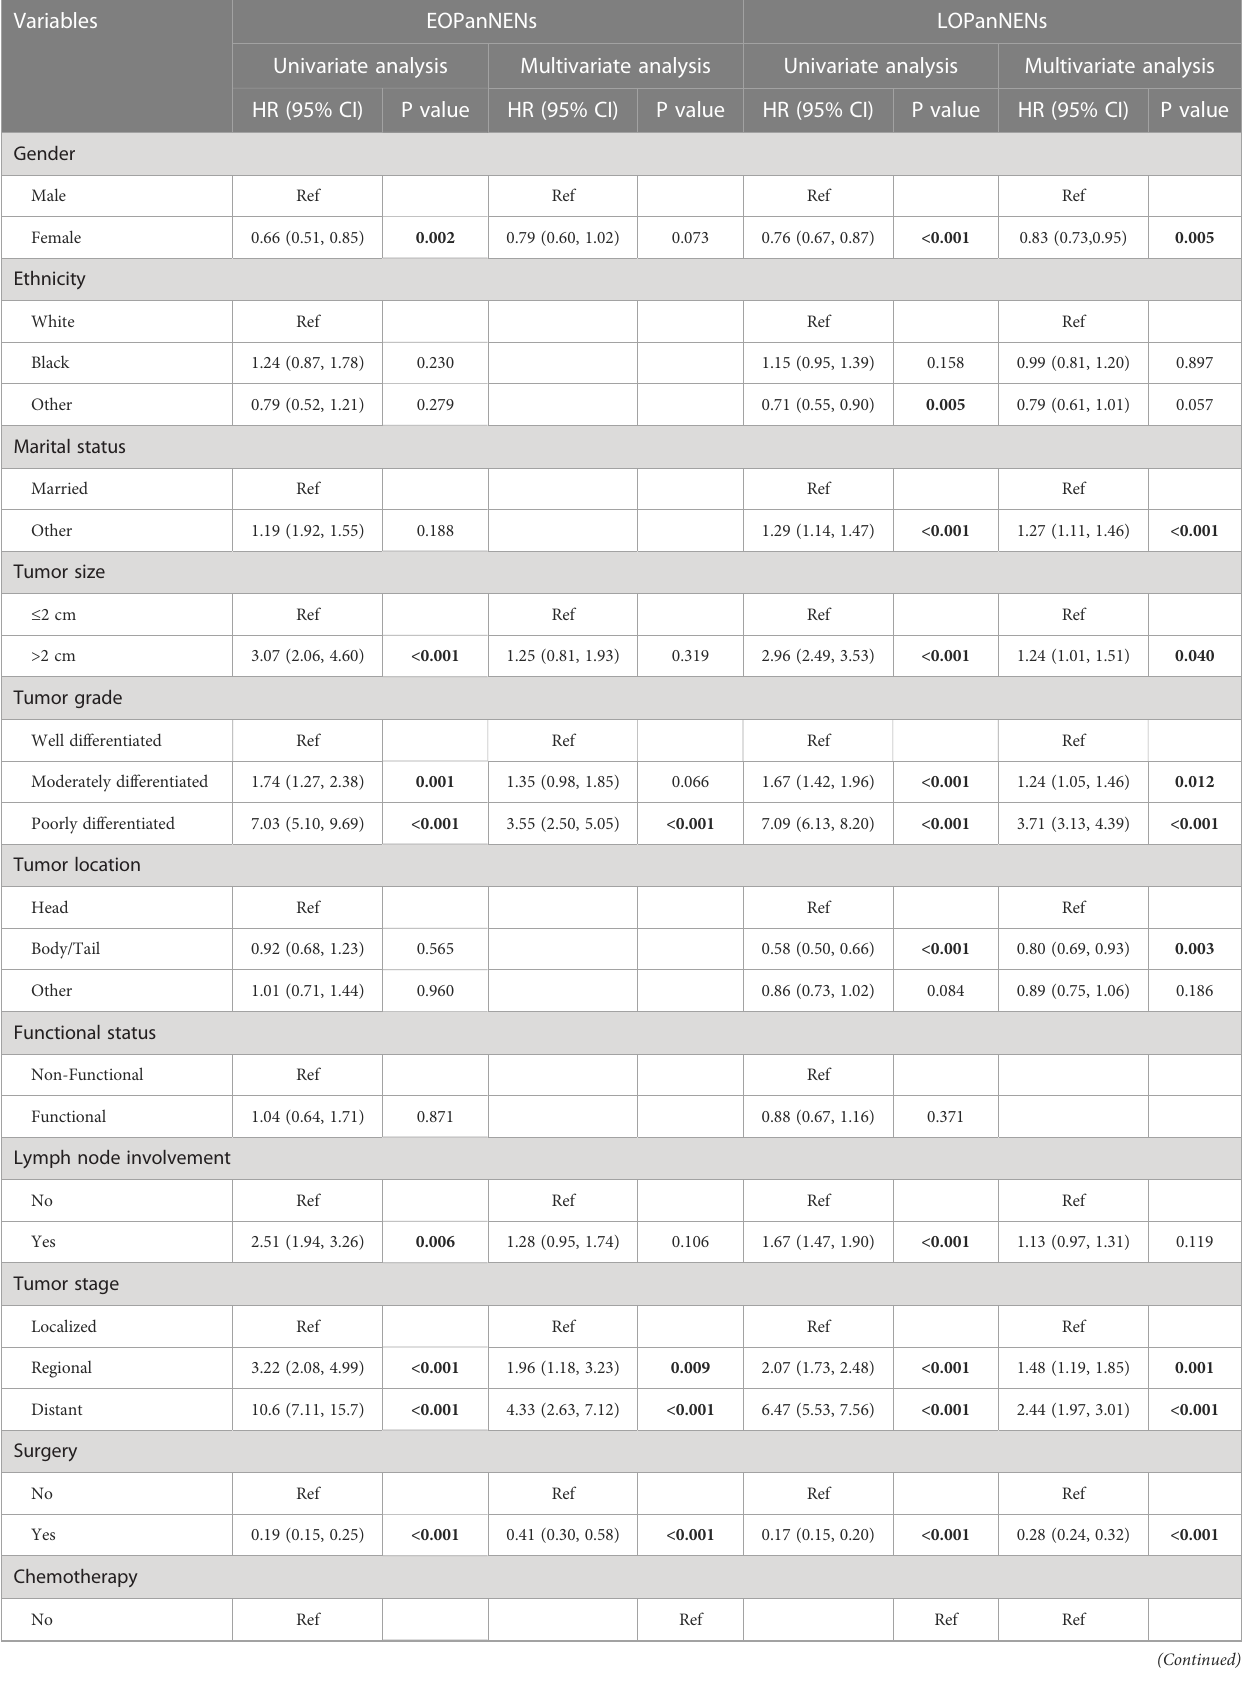
TABLE 2 Univariate and multivariate Cox regression analyses for factors affecting OS in patients with EOPanNENs or